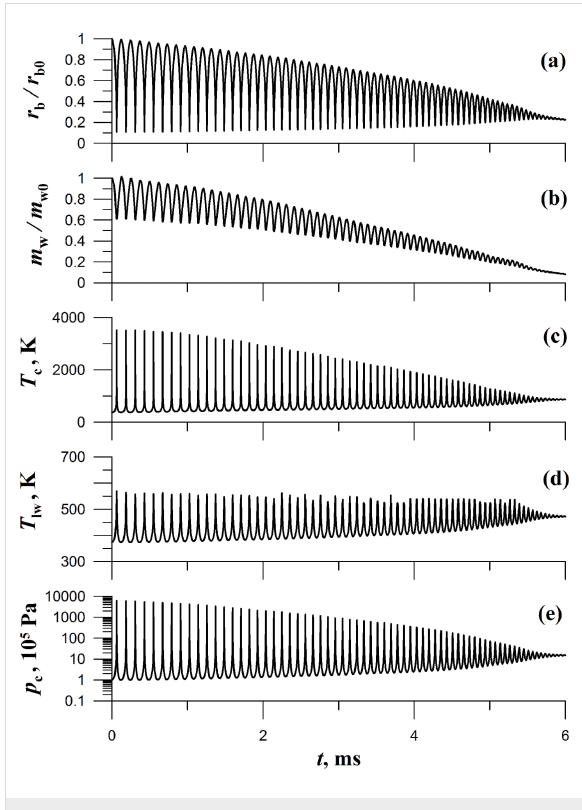
Figure 3: Time dependencies r b / r b0 , m w / m w0 , T c , T lw , and p c in a pulsating cavitation bubble. Initial parameters are the bubble radius r b0 = 0.25 cm, the pressure inside the bubble p 0 = 10 5 Pa, the vapor temperature T 0 = 373 K. The pressure in the liquid far from the bubble is p ∞ = 15 p 0 .